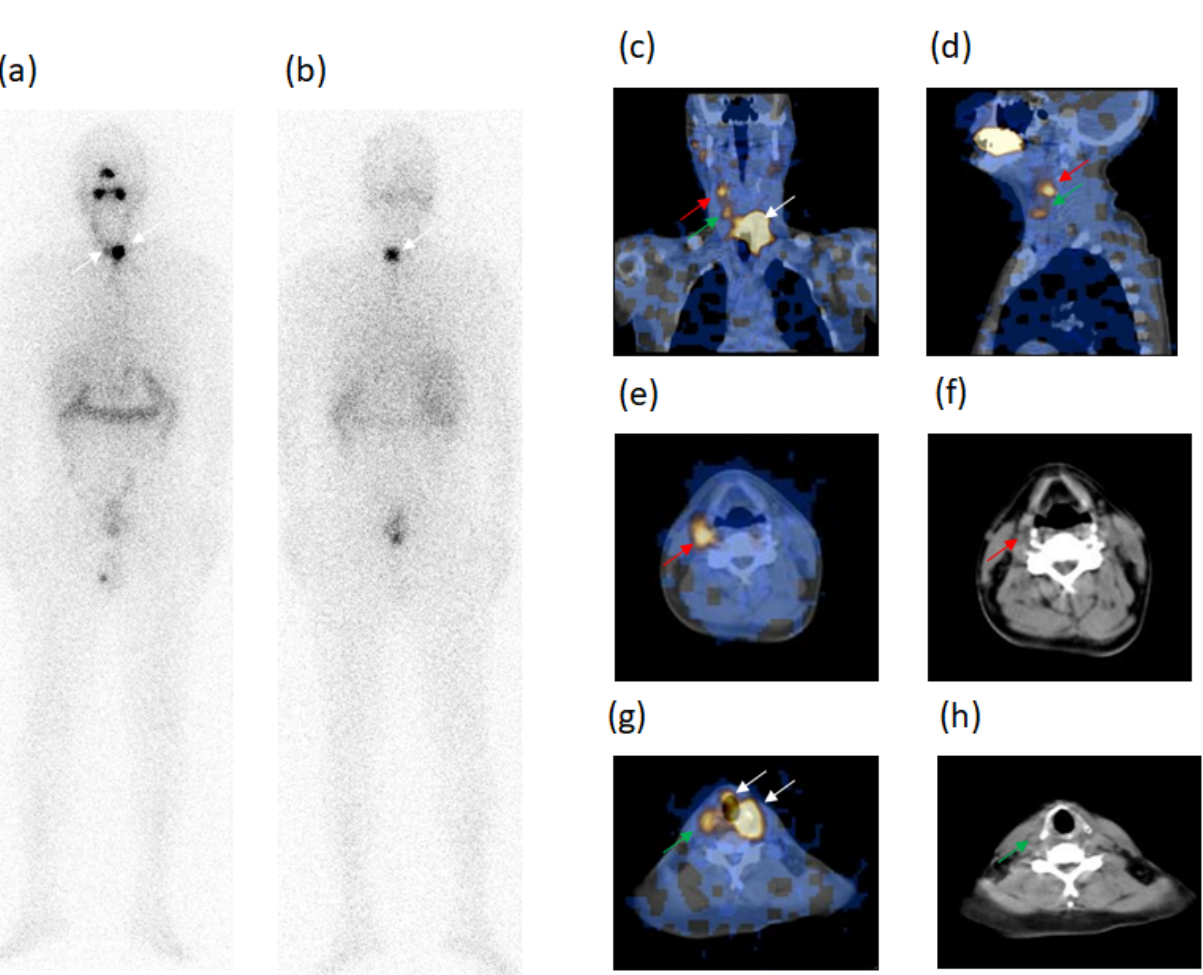
Figure 2. A 42-y-old male patient (case n. 2, Table 3), thyroidectomized for papillary carcinoma, tumor diameter 14mm, at the first radioiodine ablation. 131 I-WBS after a therapeutic dose, in both anterior ( a ) and posterior ( b ) views, showed two radioiodine-avid foci of different dimension and activity in the median region of the neck (white arrows), better evidenced in anterior view and classified as tissue residues in thyroid bed; moreover, a slightly heterogeneous radioiodine uptake was ascertained in right laterocervical region classified as unclear. Fused SPECT/CT images in coronal ( c ), sagittal ( d ) and transaxial ( e – g ) views evidenced the aforementioned two foci (white arrows) in the thyroid bed confirming the classification as residues. SPECT/CT also identified two further circumscribed foci (red and green arrows) in right laterocervical region, whose uptakes were considered unclear by WBS, classifying these as lymph node metastases, as confirmed by CT ( f – h ). Thyroglobulin levels in hypothyroidism condition: 29.3 ng/mL. AbTg: absent.